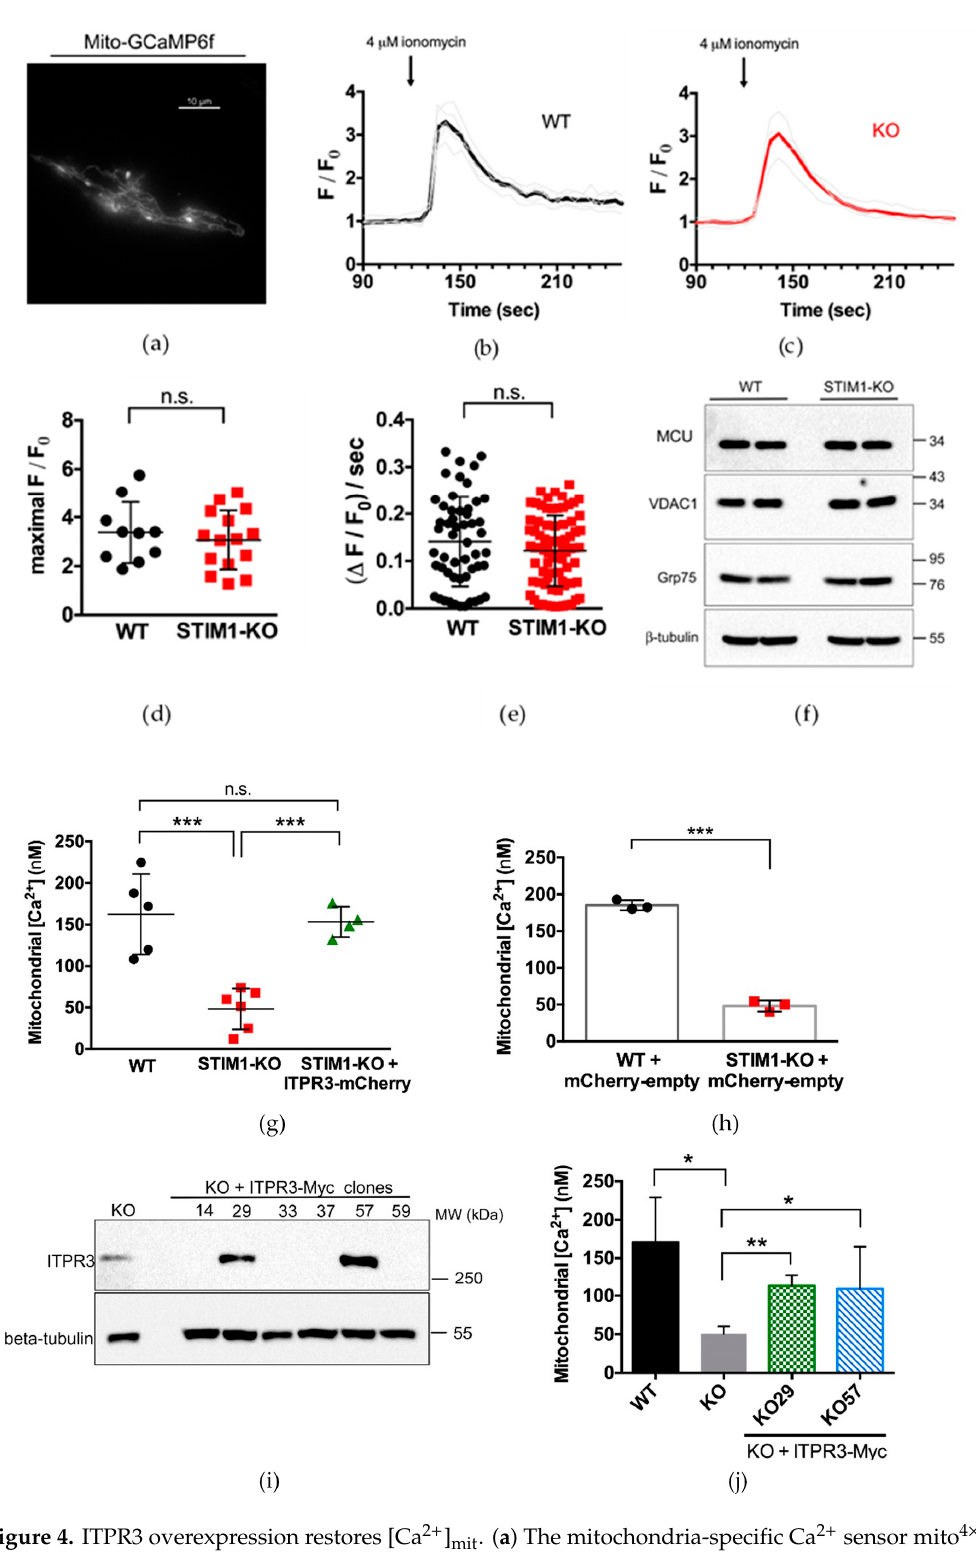
Figure 4. ITPR3 overexpression restores [Ca 2+ ] mit . ( a ) The mitochondria-specific Ca 2+ sensor mito 4× - GCaMP6f was used to measure mitochondrial [Ca 2+ ] dynamics in undifferentiated cells in response to a stimulation with ionomycin. The figure shows the distribution of the sensor under 480 nm excitation wavelength (Emission = 510 nm). ( b , c ) Forty-eight hours after transfection, cells were transferred to a bicarbonate-free L15 medium + 10% fetal bovine serum (FBS) and stimulated with a single pulse of 4 µ M ionomycin. Time course of emission of fluorescence (F) was recorded for 5 min. Single traces (grey